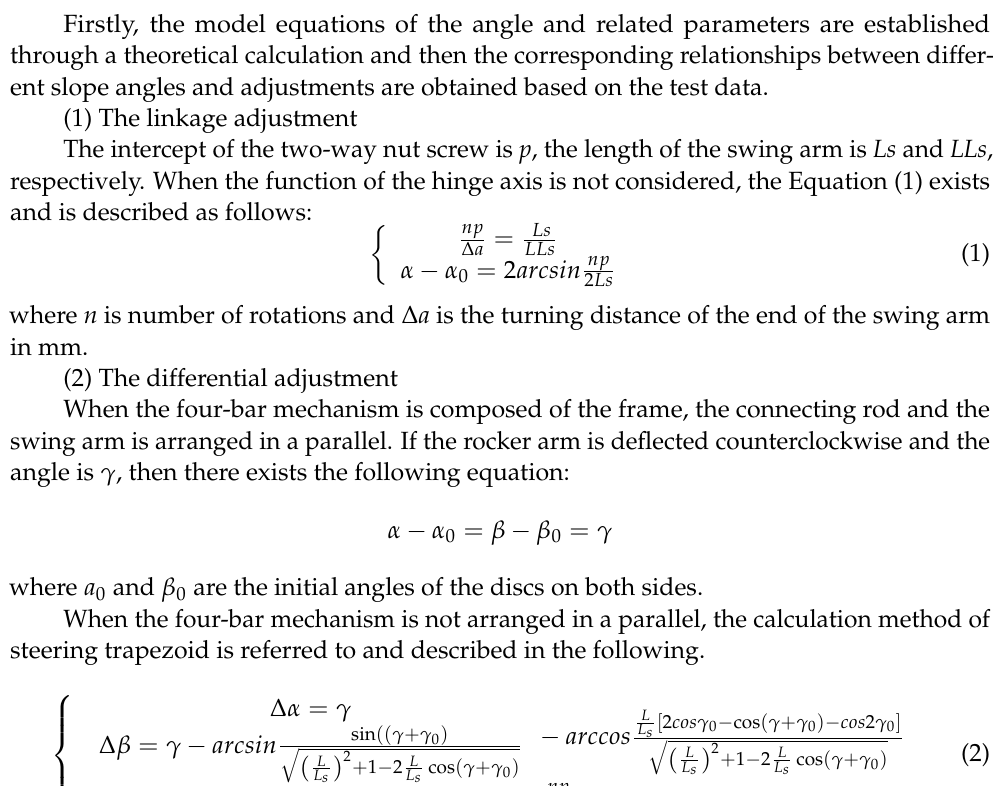
Figure 4. The schematic diagram of the adjusting mechanism.